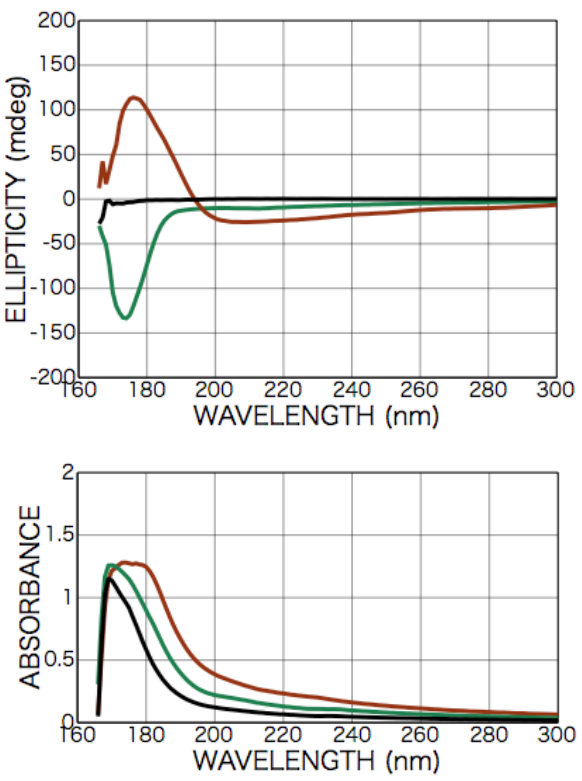
Figure 11. CD spectra of as-deposited D - (brown), L - (green) and DL -isovaline (black) films (100-nm in thickness).